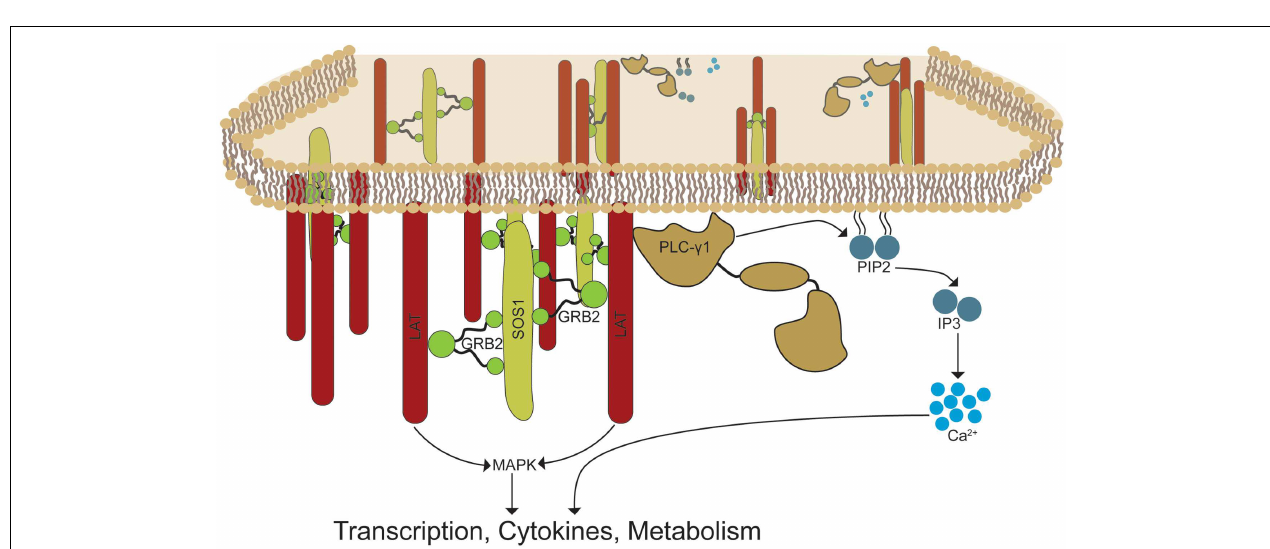
a signaling framework by linking multiple LAT proteins, thereby forming LAT signaling microclusters.The assembly of LAT clusters is critical for the recruitment and stability of signaling molecules such as PLC- γ 1 and molecules required for MAP kinase activation.These events lead to essential signal transduction required forT cell effector